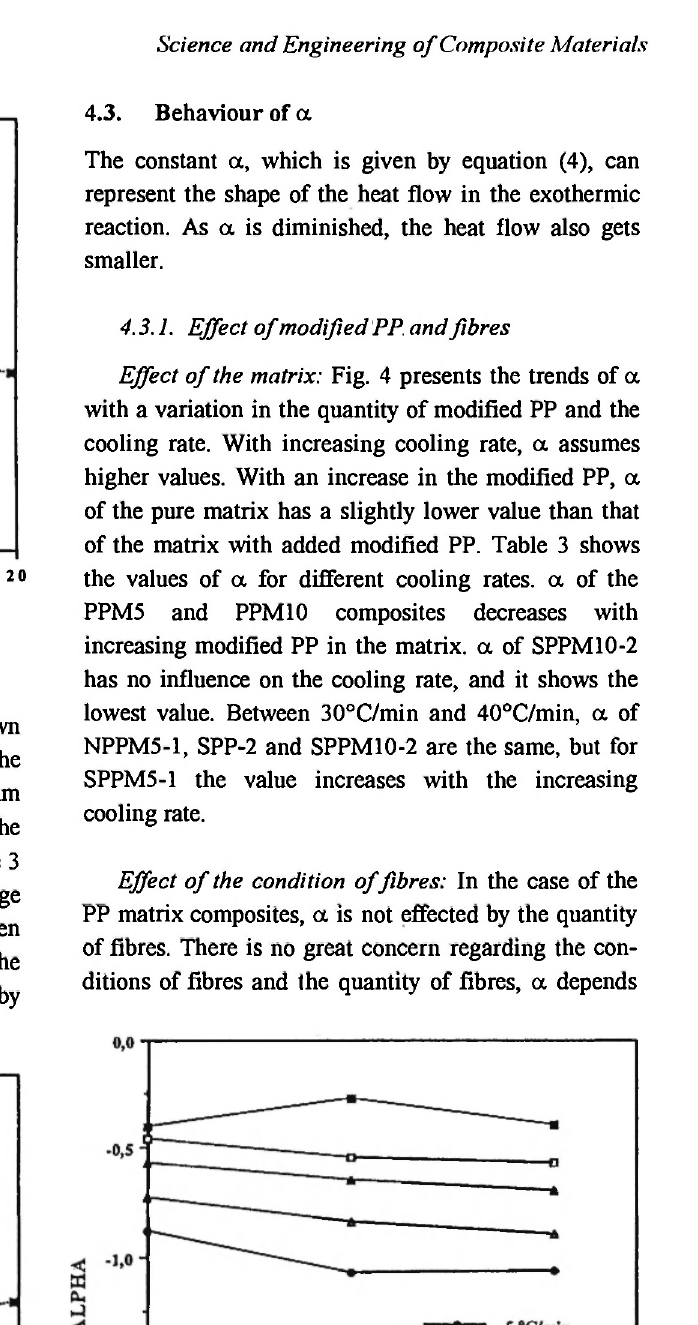
wl % οΓ Modified PP Fig. 4: Trends of ALPHA of the matrix as a function of the modified PP and the cooling